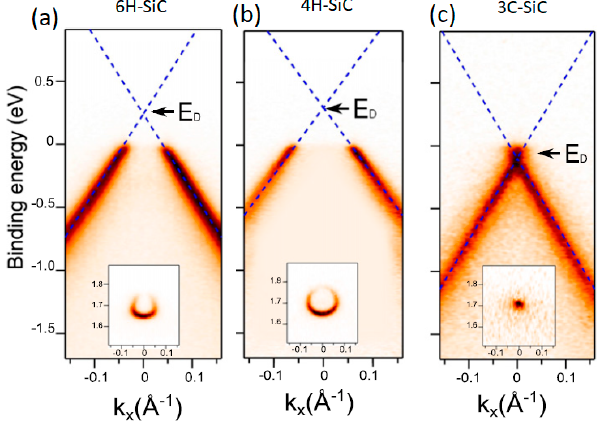
Figure 17. ARPES band structure of QFMLG formed on ( a ) 6H SiC, ( b ) 4H-SiC, and ( c ) 3C-SiC. Reprinted with permission from Reference [75]. Copyright (2014) IOP Publishing Ltd.